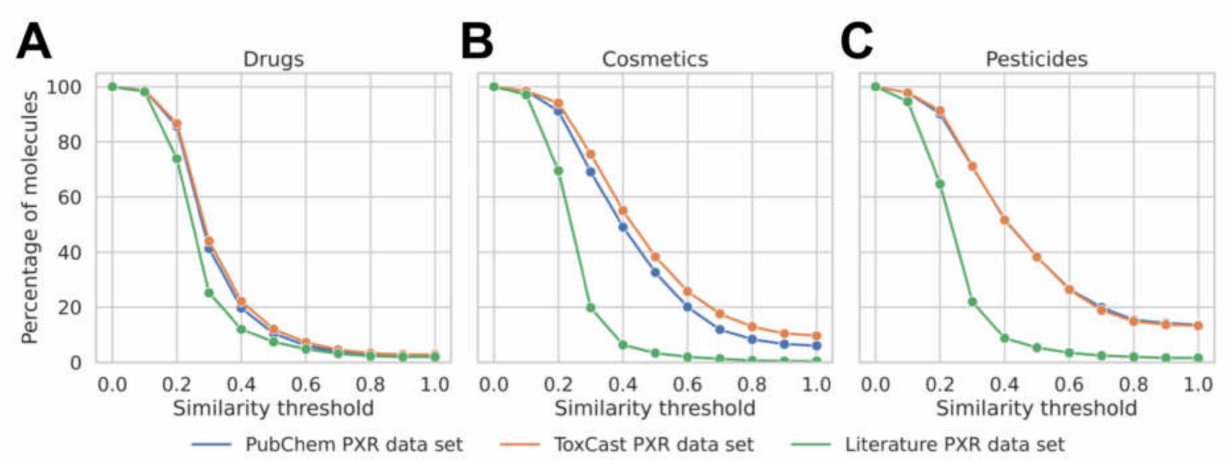
Figure 1. Fraction of molecules ( y -axis; ( A ) drugs, ( B ) cosmetics, ( C ) pesticides) in each reference data set covered by the PubChem, ToxCast, and Literature PXR data sets (indicated by color) at different similarity thresholds ( x -axis).